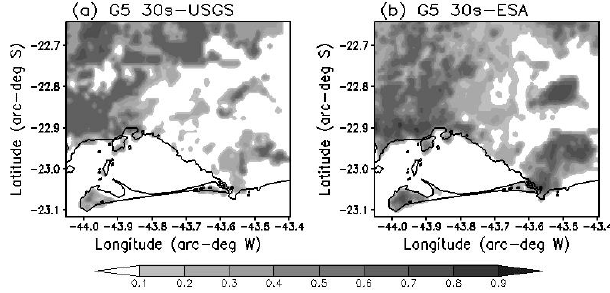
Figure 6. Vegetation-cover-fraction shaded maps for G5, processed with (a) 30arc-sec USGS and (b) 30arc-sec ESA